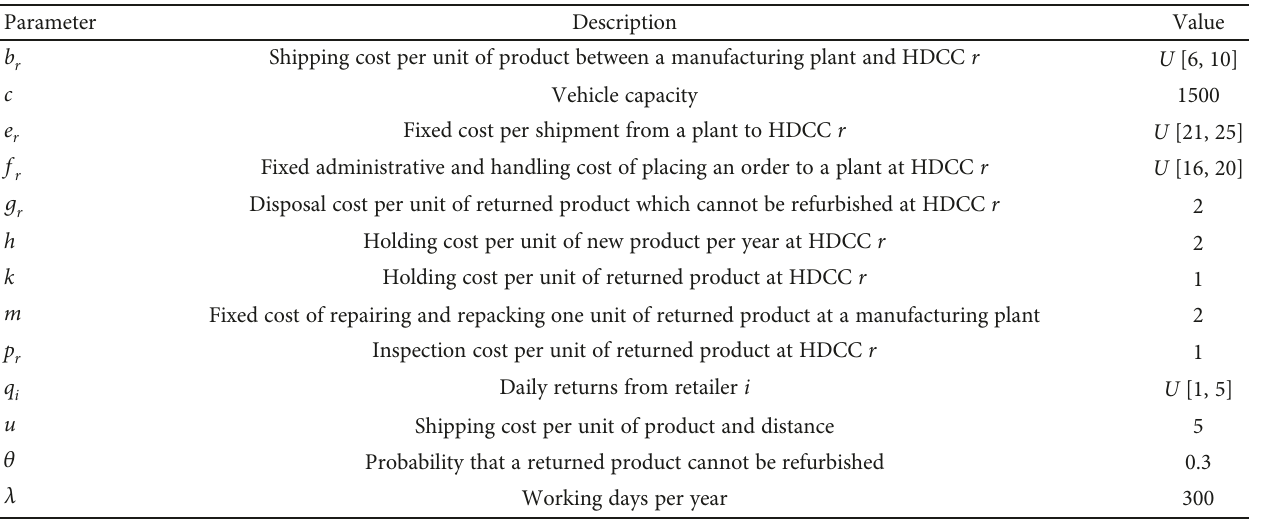
Table 3: LIRP parameters.